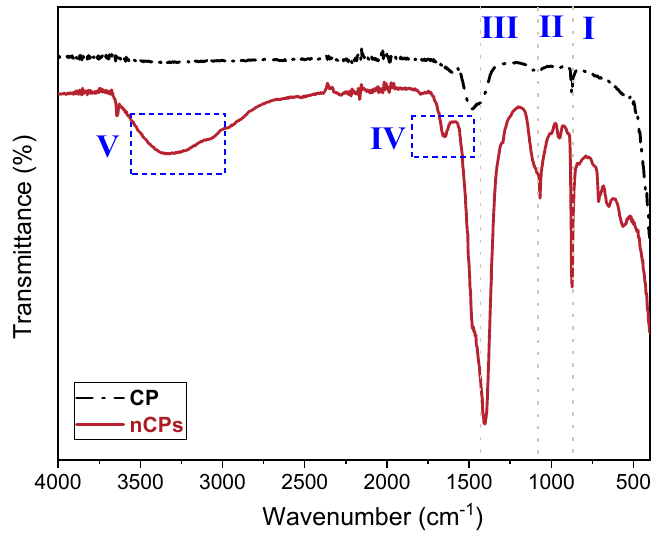
Figure 4. FTIR spectra of CP and nCPs.